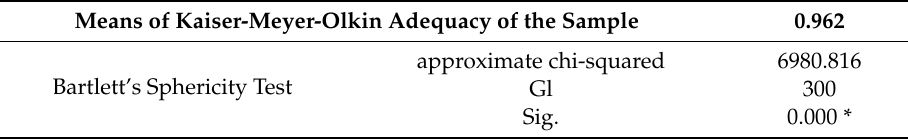
Table 9. Kaiser–Meyer–Olkin (KMO) and Bartlett’s